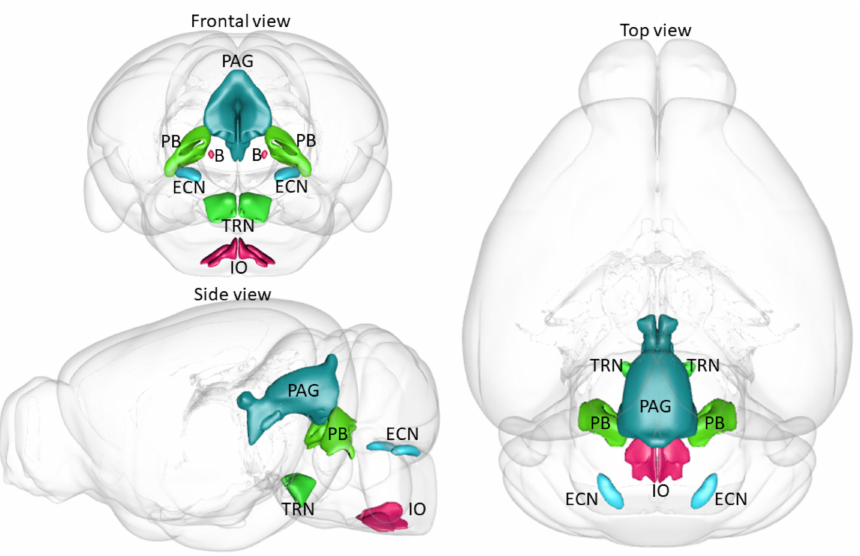
Figure 2. Mouse brain areas containing a significant amount of CRH-producing cells. The figure was created with the help of scalablebrainatlas.incf.org. Red: high CRH density; B: Barrington’s nucleus; IO: inferior olivary complex. Green: repeatedly confirmed moderate CRH density; TRN: tegmental reticular nucleus, PB: parabrachial nucleus. Blue: moderate CRH density; ECN: external cuneate nucleus, PAG: periaqueductal